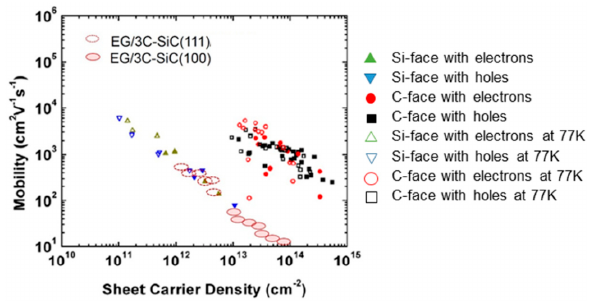
Figure 13. Mobility and sheet carrier density for EG on 3C-SiC/Si combined with those of monolayer EG on the Si-face of 4H-SiC and 6H-SiC substrates at 300 and 77 K from Tedesco et al. [36]. Reprinted with permission from Reference [21]. Copyright (2020) American Chemical Society.